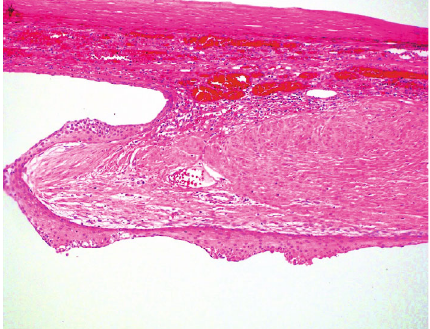
Figure 2: Strati fi ed squamous epithelial lined splenic cyst (epidermoid cyst) (H&E 100 magni fi cation;